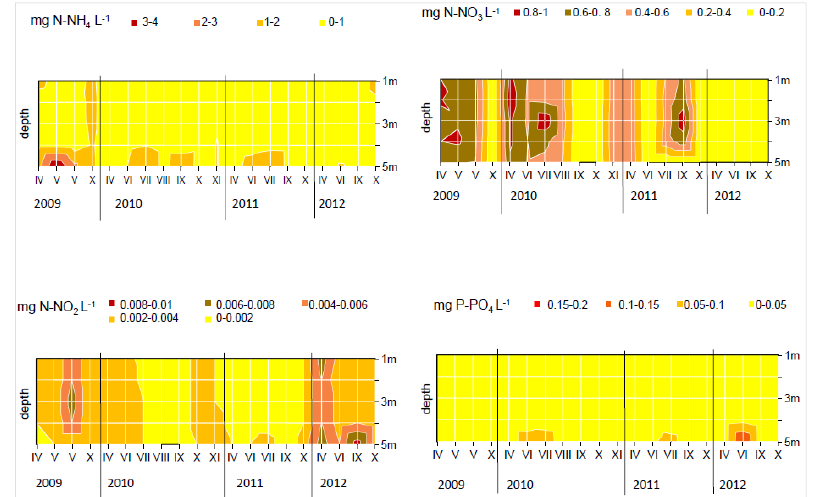
Figure 4. Concentration of ammonium, nitrite, nitrate nitrogen and orthophosphates in vertical profile at station A.